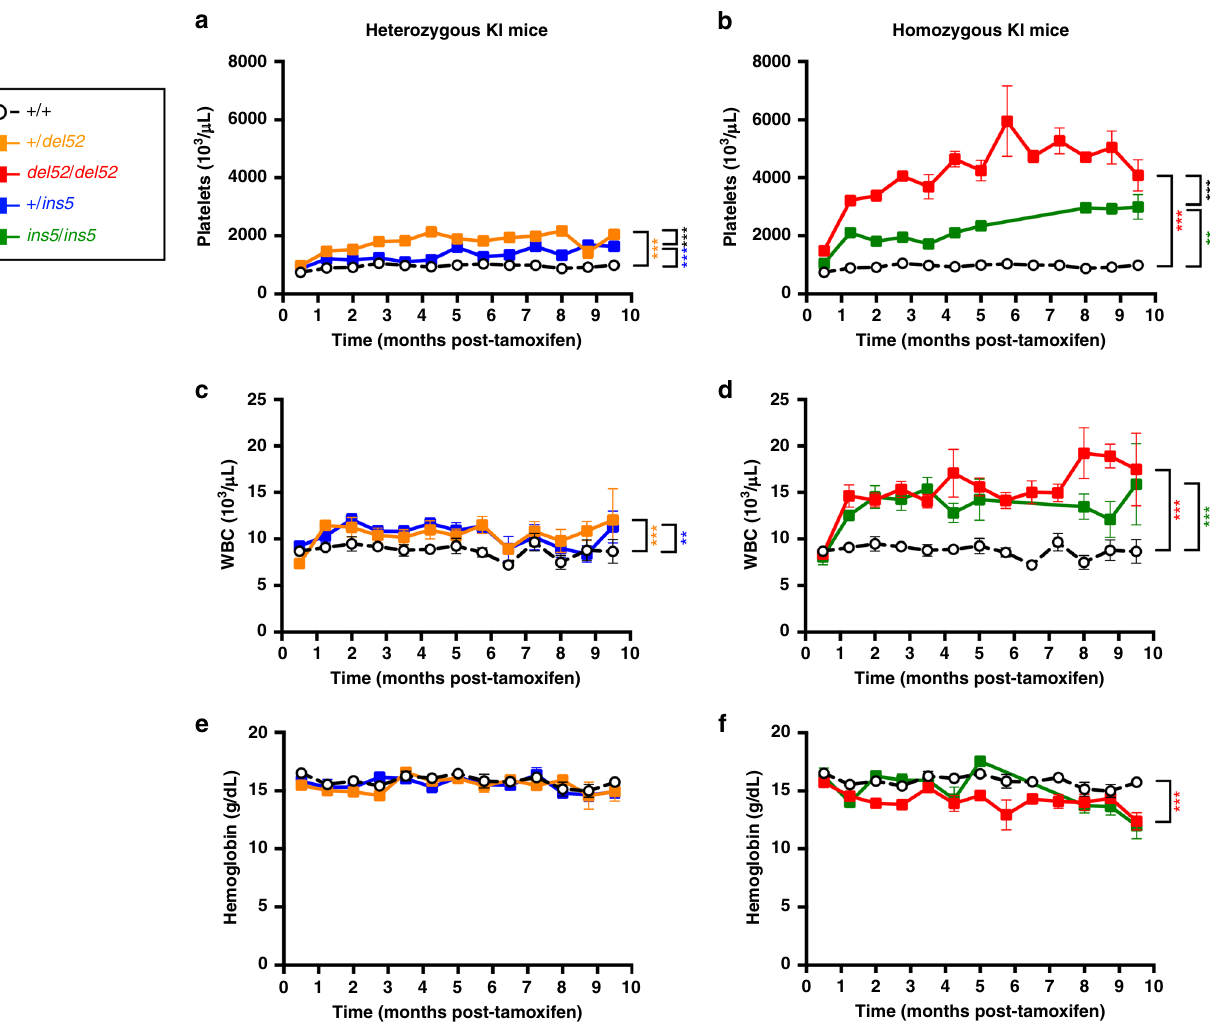
Fig. 2 Severity of KI mouse phenotype depends on the mutation and the zygosity. Blood parameters including a , b platelets, c , d WBC counts and e , f hemoglobin levels were determined in wt + / + (open circles with connecting black dashed line, n = 16, 18, 15, 11, 11, 8, 13, 7, 14, 11, 5, 6, 4 for platelets, n = 34, 25, 26, 25, 19, 18, 17, 12, 19, 13, 10, 13, 7 for WBC and n = 36, 26, 28, 25, 21, 19, 20, 11, 19, 11, 9, 14, 9 for hemoglobin), heterozygous + /del52 (orange squares and solid line, n = 18, 20, 15, 12, 10, 7, 11, 7, 12, 12, 8, 5, 10 for platelets, n = 18, 19, 15, 13, 11, 7, 11, 7, 14, 11, 7, 5, 3 for WBC and n = 19, 20, 16, 13, 11, 8, 11, 7, 13, 9, 7, 5, 3 for hemoglobin) and + /ins5 (blue squares and solid line, n = 20, 7, 13, 18, 11, 13, 10, 5, 4, 4, 5, 8, 7 for platelets, n = 21, 8, 12, 19, 11, 12, 10, 5, 5, 4, 5, 8, 9 for WBC and n = 20, 7, 12, 18, 11, 13, 13, 5, 5, 4, 5, 8, 7 for hemoglobin) and homozygous del52/del52 (red squares and solid line, n = 14, 14, 10, 7, 6, 3, 8, 3, 7, 5, 3, 3, 4 for platelets, n = 14, 14, 10, 8, 7, 5, 8, 2, 7, 5, 4, 3, 4 for WBC and n = 16, 16, 10, 7, 7, 5, 8, 3, 7, 4, 3, 3, 4 for hemoglobin) and ins5/ins5 (green squares and solid line, n = 6, 1, 6, 8, 9, 7, 5, 6, 5, 5 for platelets, n = 8, 1, 7, 9, 9, 6, 6, 6, 6, 4 for WBC and n = 6, 1, 7, 9, 9, 8, 5, 6, 5, 6 for hemoglobin) mice after tamoxifen induction. N represents the number of individual mouse and varies depending on time of sampling during the course of the experiment, as indicated in the Source data fi le. Data are the means ± SEM. Signi fi cance was determined using ANOVA with Tukey ’ s multiple comparison test: ** p = 0.001, *** p ≤ 0.0001 ( a , b ); ** p ≤ 0.001, *** p = 0.0007 ( c ); *** p < 0.0001 ( d ); *** p = 0.0008 ( f ). Source data are provided as a Source data fi